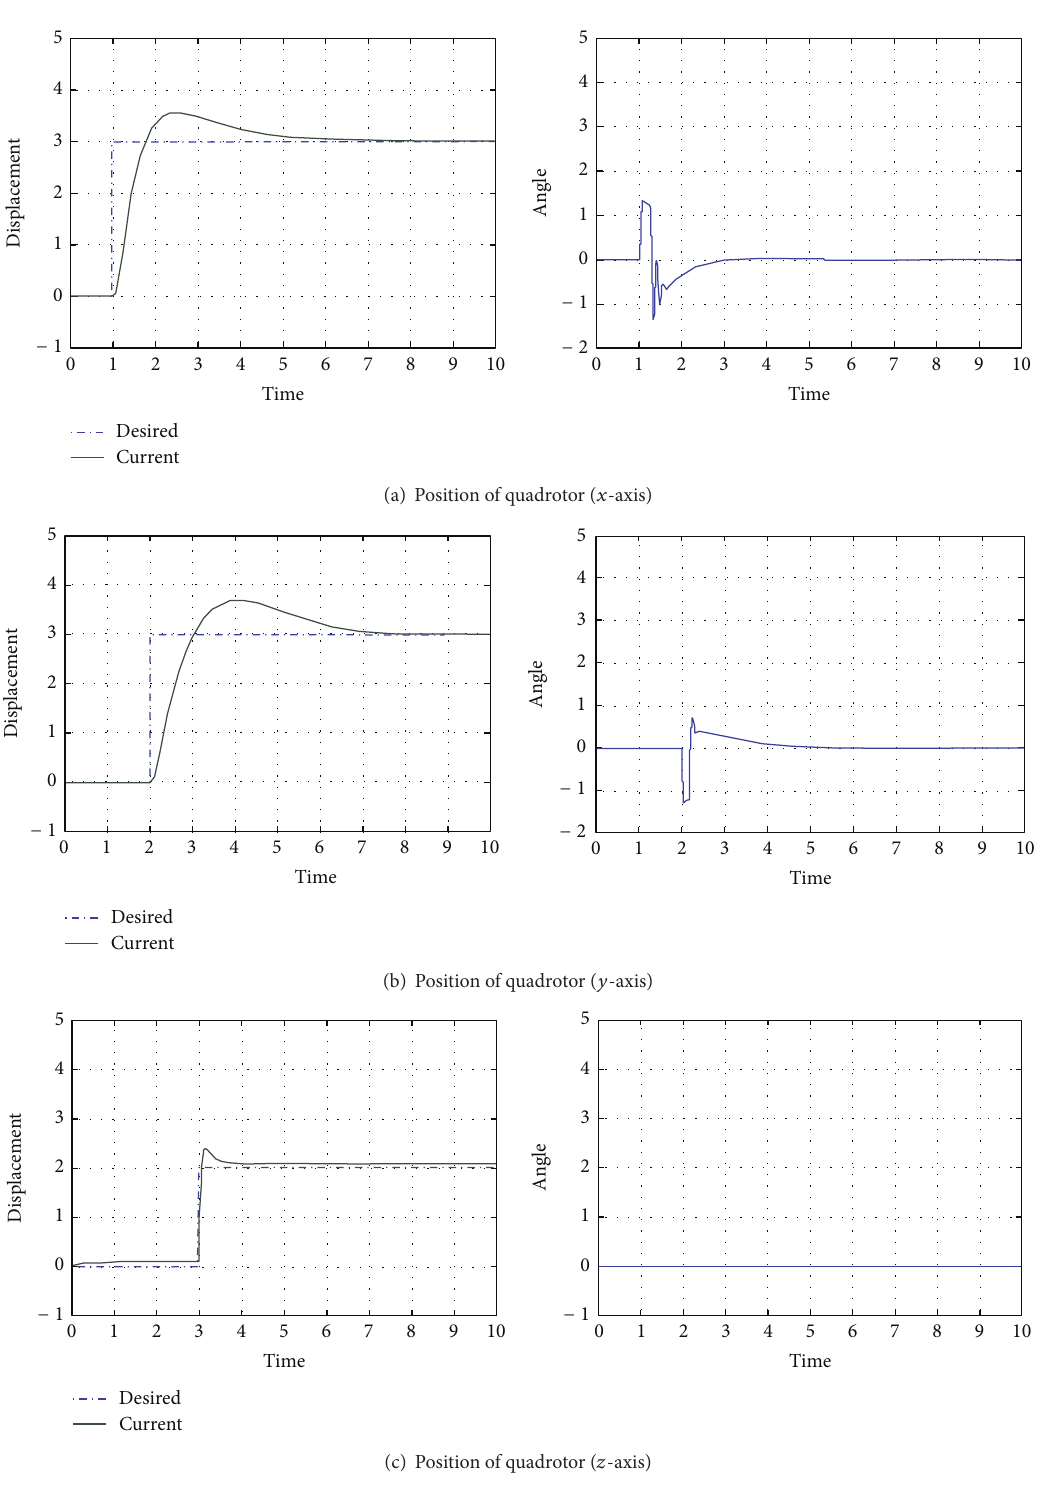
Figure 12: Tracking displacement without